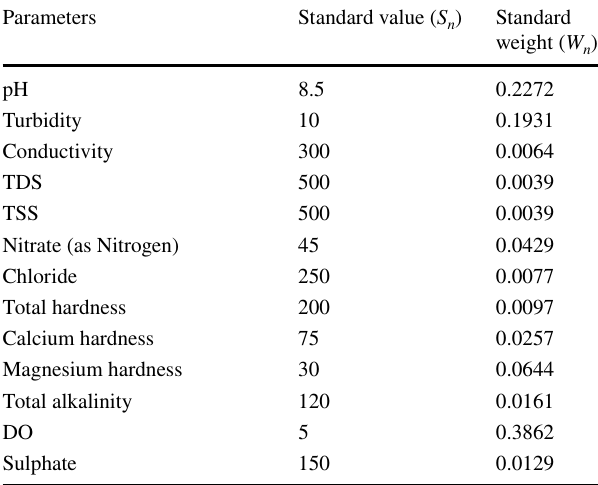
Table 4 Standard values and standard weights of various parameters